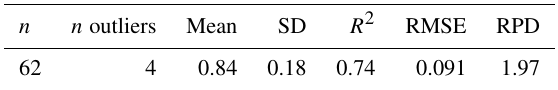
Table 5. Cross-validation statistics of modified partial least-squares regression for the models used to predict soil bulk densities (gcm − 3 ) from MIR